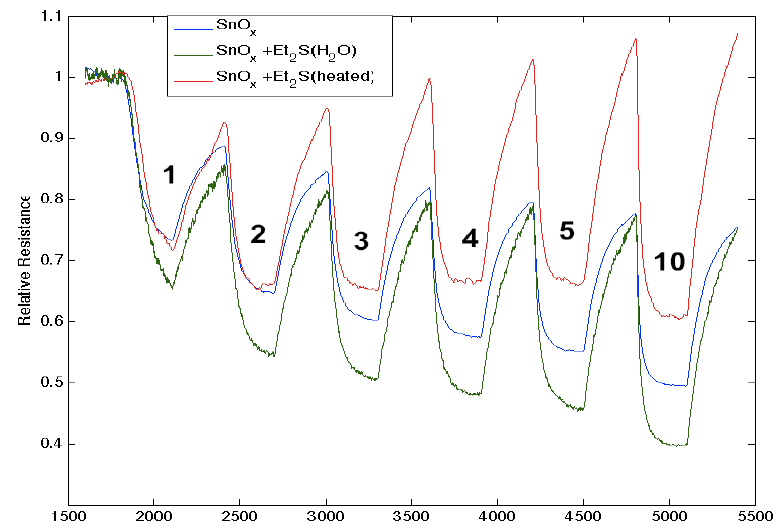
Figure 7. Response of diethyl sulfide, Et S, -treated tin oxide-deposited porous silicon 2 . Exposure to SnO -treated PS interface ( blue line ). Initial exposure (PS) interface to NH 3 x to Et S with water present ( green line ). Response of diethyl sulfide-treated tin 2